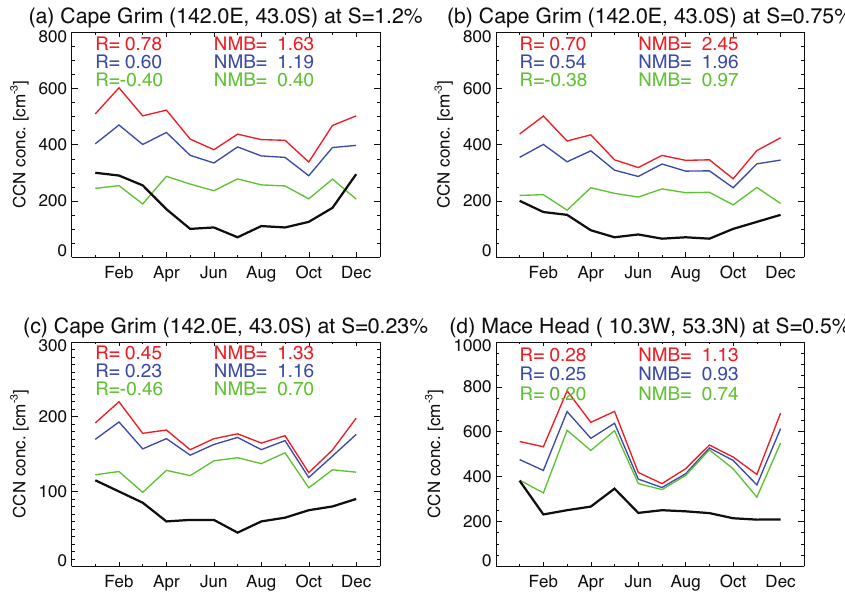
Figure 28. Annual cycle of CCN concentrations at Cape Grim (supersaturations ( s ) of 1.2% in a , 0.75% in b , and 0.23% in c ) and Mace Head ( s of 0.5% in d ). The measured CCN concentrations are shown in black, and the simulated CCN in red for the BASE run, blue for the LowNUC run, and green for the NoNUC run. Correlation ( R ) and normalized mean bias (NMB) are